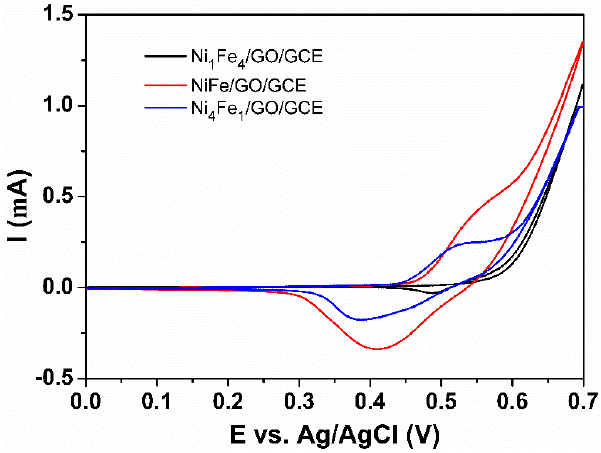
Figure 5. CVs of Ni 1 Fe 4 /GO/GCE, NiFe/GO/GCE, and Ni 4 Fe 1 /GO/GCE in 0.1 M NaOH solution in the presence of 1.0 mM glucose at a scan rate of 10 mV/s.